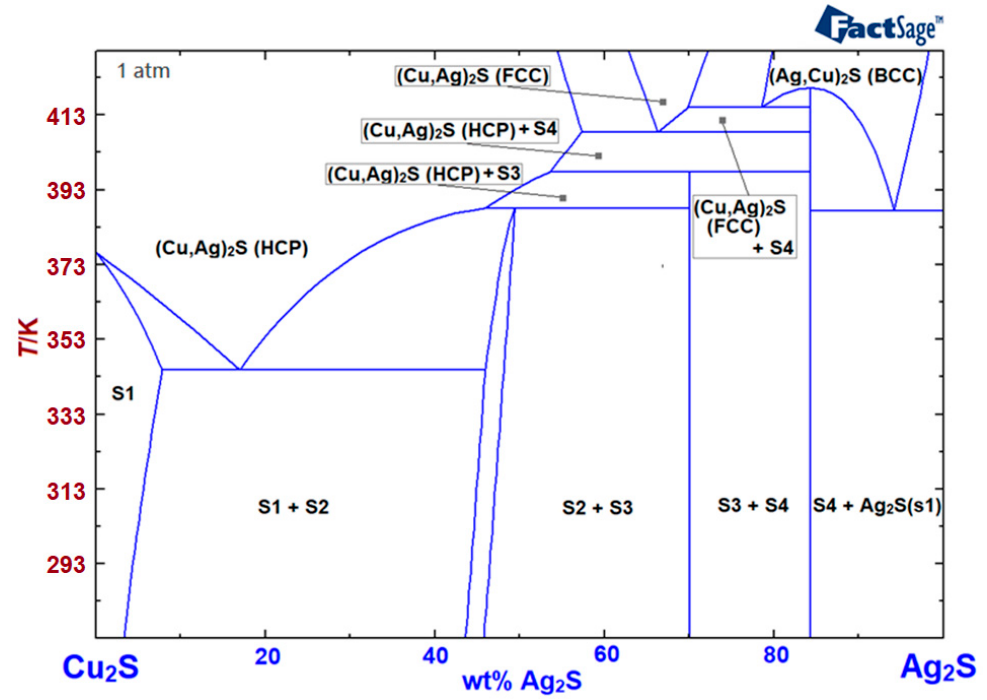
Figure 10. Magnified portions of the optimized phase diagram in the temperature range 273–430 K.